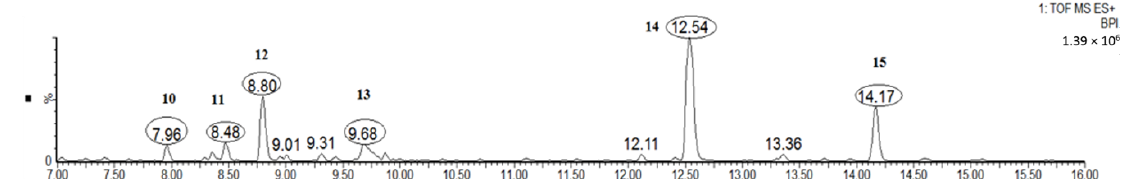
Molecules 2019 , 24 , x FOR PEER REVIEW Figure 5. Typical total ion chromatogram of diarylheptanoids (peaks 10 – 15) of the MRB extract. Figure 5. Typical total ion chromatogram of diarylheptanoids (peaks 10–15) of the MRB extract.